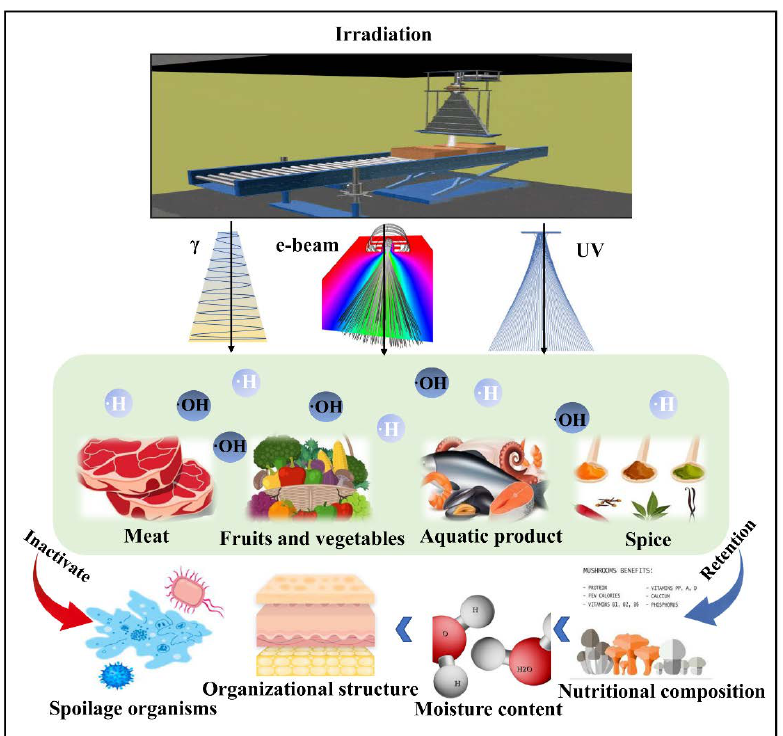
Figure 2. The food system under irradiation technology ( γ, gamma radiation; e -beam, electron beam; UV, ultraviolet). Irradiated